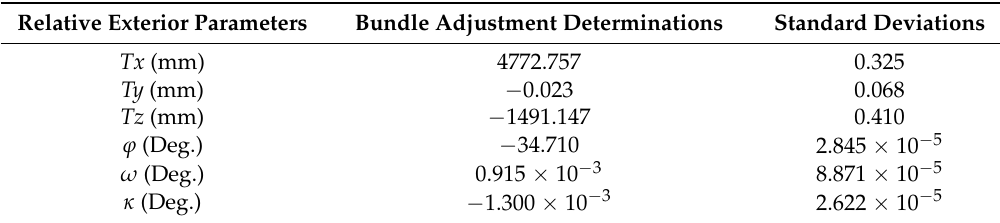
Table 2. Bundle adjustment results of the relative exterior parameters.